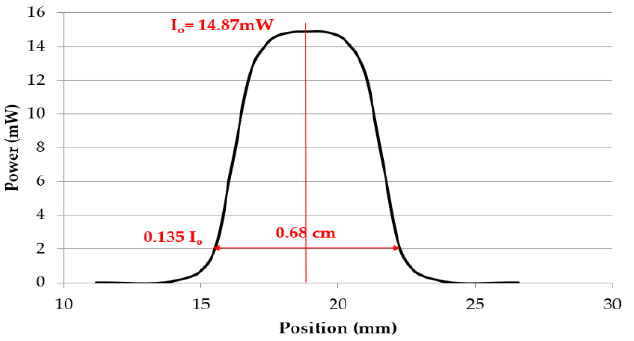
Figure 4. Gaussian curve of He-Ne laser ( λ = 632.8 nm) using the knife-edge method.